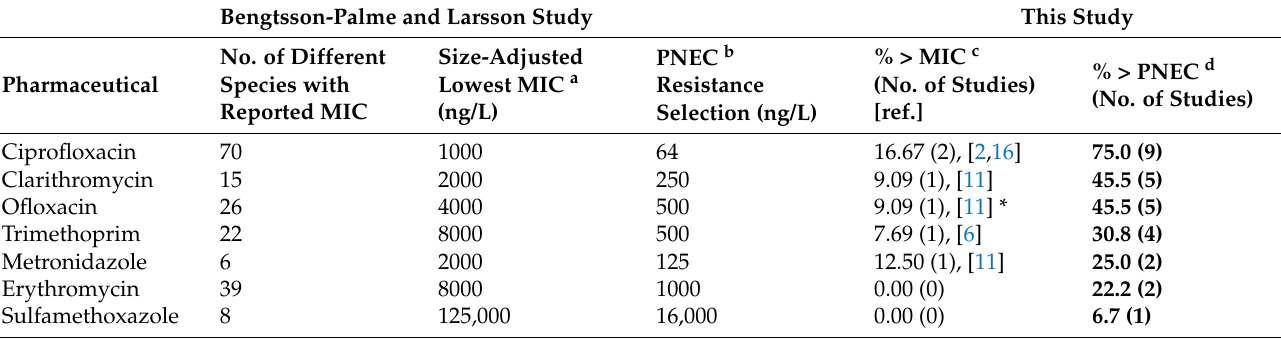
Table 8. Classification of the pharmaceuticals of greatest concern sorted according to the percentage of studies in which the reported concentrations in effluents exceeded the PNECs for resistance selection (adapted from Bengtsson-Palme and Larsson,